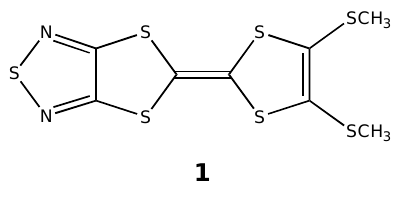
Figure 1. Structure of compound 1.